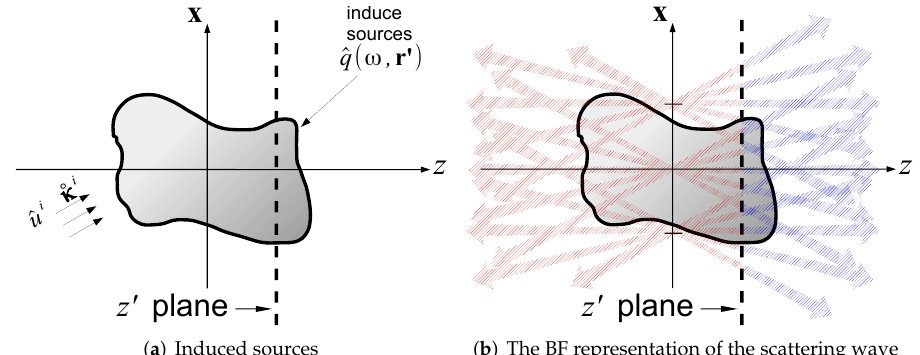
Figure 4. The scattering mechanism within the propagating frame formulation. The incident field that propagates through the medium (see subplot ( a )) gives rise to induced sources. At each z = const . plane, these sources are expanded by the forward/backward propagating BFs, giving rise to the forward/backward scattered fields depicted in subplot ( b ) in blue and red,